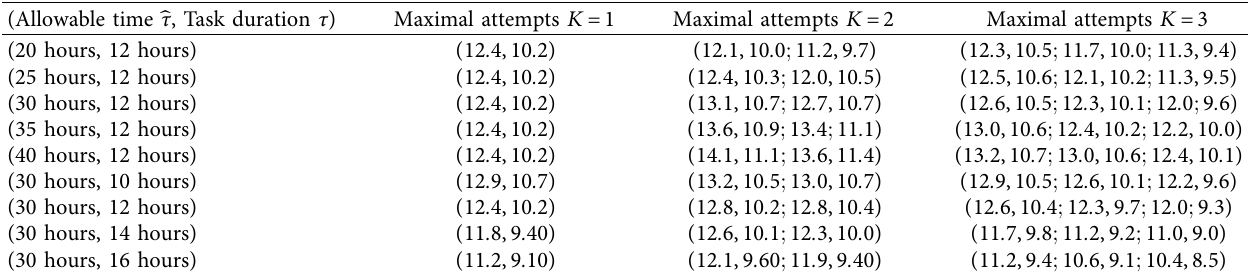
Table 2: Optimal abandon thresholds under task success criteria II given different allowable time and task